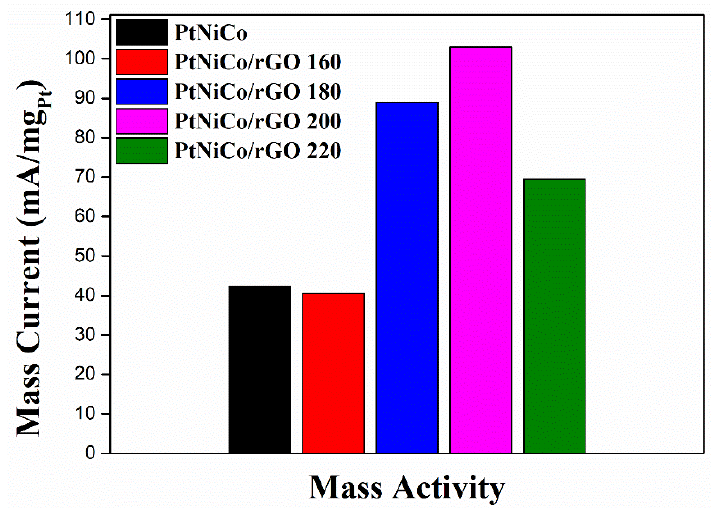
Figure 9. Histogram of mass activities of different catalysts for MOR.